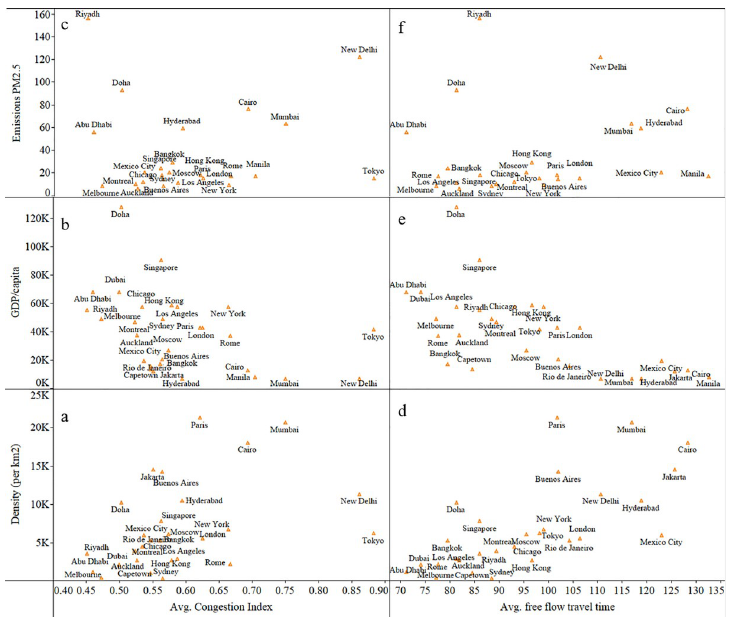
Fig 2. Comparison of cities. a.-c. average CI of 29 cities are fitted against the population density, GDP/capita and vehicular emissions respectively and d.-f. the free flow speed of 29 cities are fitted against the population density, GDP/ capita and vehicular emissions